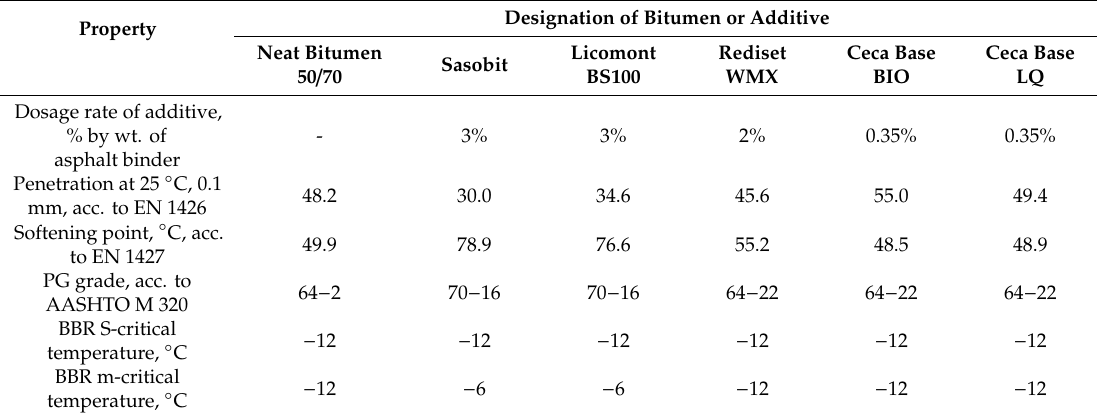
Table 2. Properties of bitumen 50 / 70 with warm mix asphalt additives.